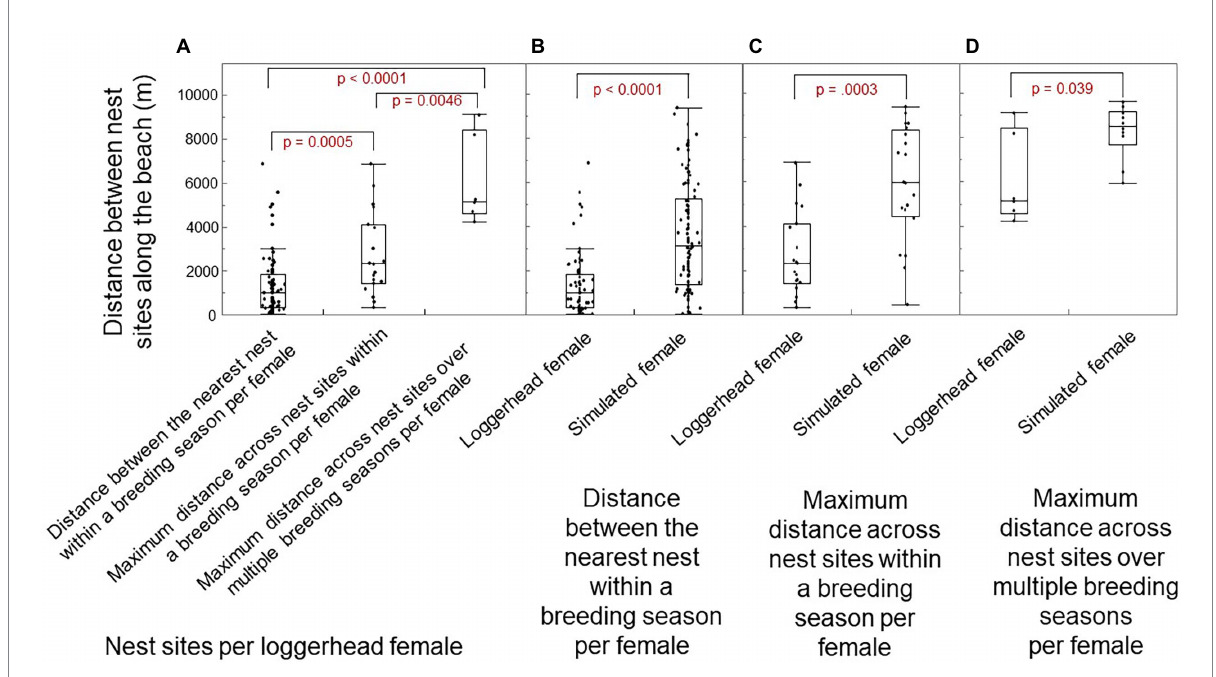
FIGURE 6 Distances among nests along the beach-length axis of Keewaydin Island for loggerhead females and simulated females. (A) Distance among nests per loggerhead female within and across breeding seasons. (B) Distance between the nearest-neighbor nests within a breeding season by female type. (C) Longest distance across nests within a breeding season by female type. (D) Longest distance across all nests over multiple breeding seasons by female type. The median shows as a line across the box. The ends of the box are the 25 and 75th quantiles (i.e., quartiles). Whiskers enclose all data except outliers. Significant differences show as